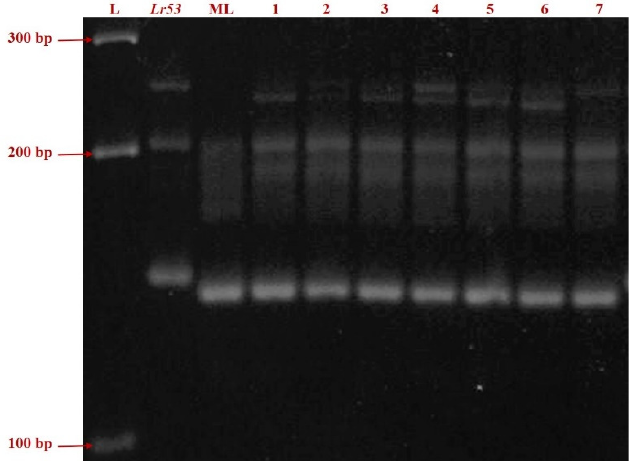
Figure 2. PCR amplification of the SSR marker gwm508 in Lr53 genetic stock, negative control ML and seven germplasm lines (Left to Right: L = ladder; Thatcher + Lr53 = positive control; ML = Mandsaur Local = negative control; 1. IC138898; 2. IC47022; 3. IC535116; 4. IC535133; 5. IC535139; 6. IC